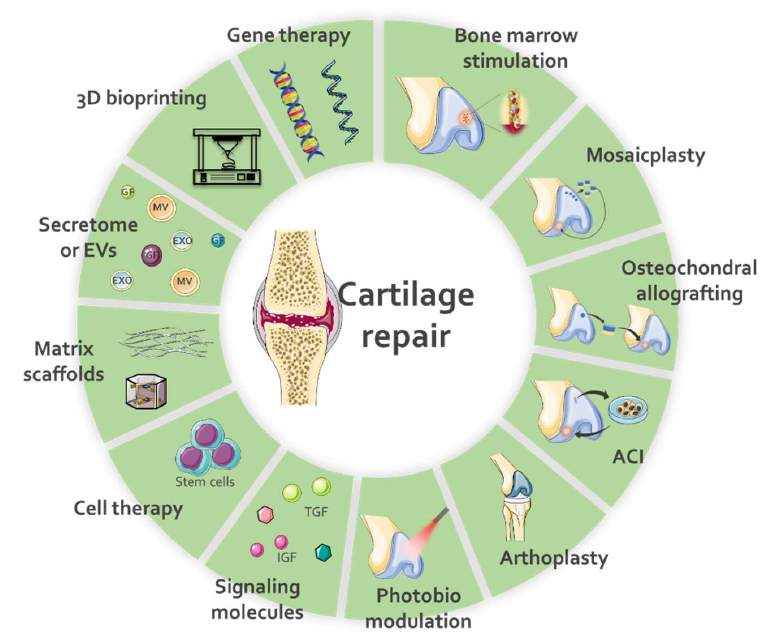
Figure 1. Cartilage repair treatments. This scheme represents some of the main treatments already used or under development for cartilage repair. ACI = autologous chondrocyte implantation; EVs = extracellular vesicles. The images were obtained from Servier Medical Art (http://smart.servier.com/, Accessed on 7 April 2022), licensed under a Creative Commons Attribution 3.0 Unported License.